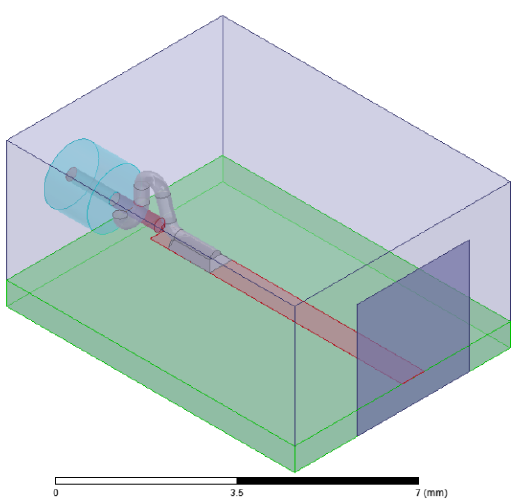
Figure 3. Structure-electromagnetic analysis model for FCWI.